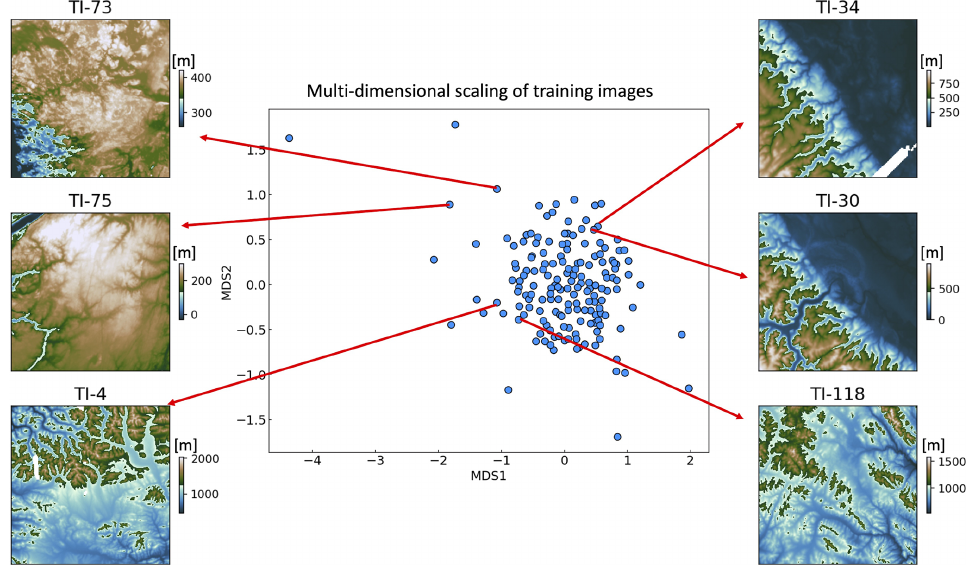
Figure 5. Visualization of the metric space using multi-dimensional scaling (MDS) into a two-dimensional Cartesian space. Each dot on the plot represents a TI. It shows TIs with similar morphology are close in this metric